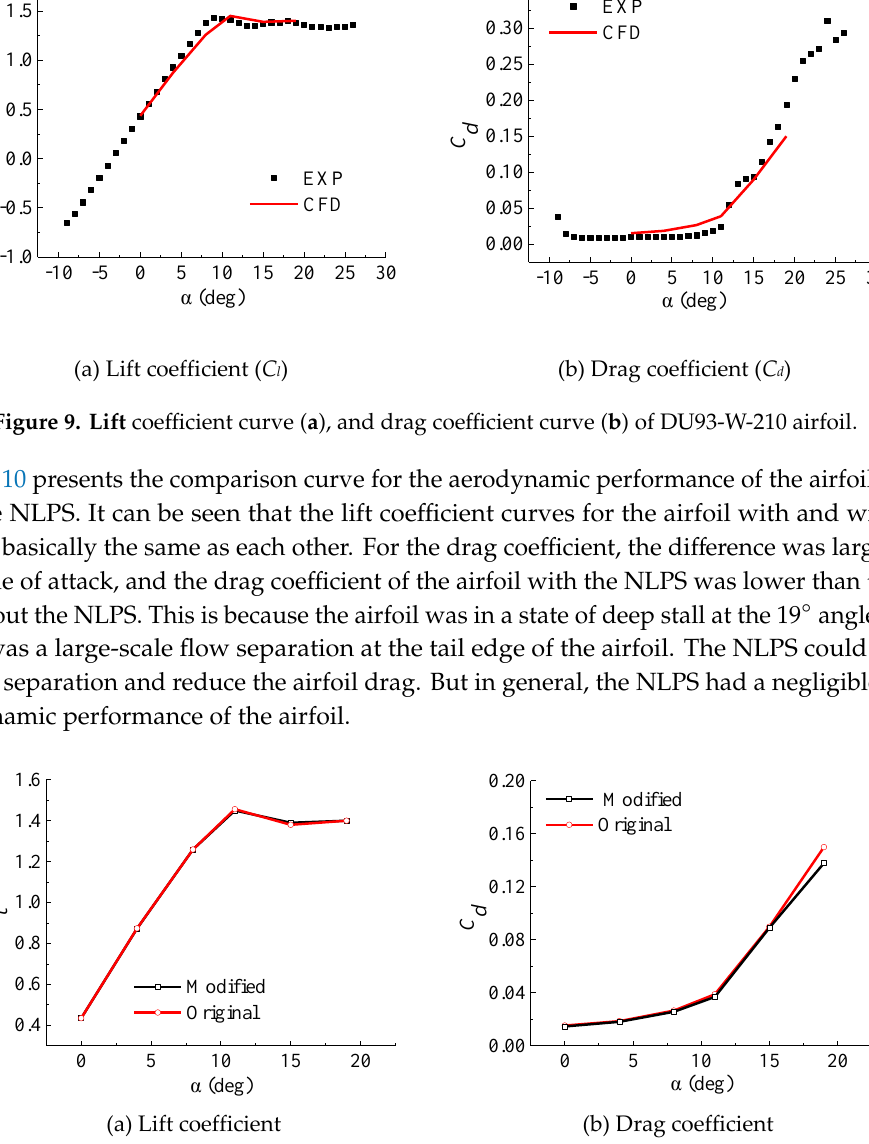
Figure 11. C p distribution of the airfoil with and without the NLPS. Figure 12 indicates the noise directivity distribution of the airfoil without the NLPS. Figure 12a shows the distribution of noise monitoring points, which were located on the inner symmetrical surface of the airfoil section. The airfoil was equipped with 36 monitoring points in a circle. Figure 12b presents the distribution of the noise directivity at different radius positions. Figure 12c shows the distribution of noise directivity for different angles of attack. Firstly, the directivity distribution of airfoil noise was distributed as a dipole. The noise could be subdivided into monopole, dipole, and quadrupole noise. The dipole noise was caused by the interaction of turbulence with the boundaries of objects. Therefore, the theoretical conclusions qualitatively verified the reliability of the calculation results. The magnitude of the sound pressure level (SPL) decreased with increases of the radius; therefore, the SPL was low far away from the noise source. Secondly, the amplitude of the SPL increased with increases of the angle of attack, and the plane of symmetry of the dipole distribution varied with the angle of attack.